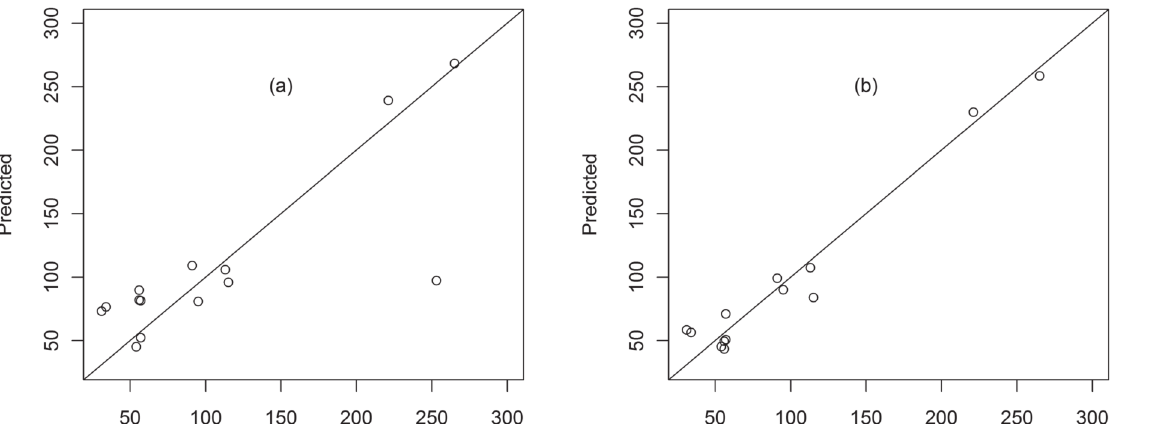
Fig. 3. Factors pattern after varimax rotation. Following are the symbol descriptions: 1: temperature stability, 2: rain- fall, 3: discharge, 4: sediment load, 5: surface area of drainage basin, 6: weighted latitude, 7: water temperature